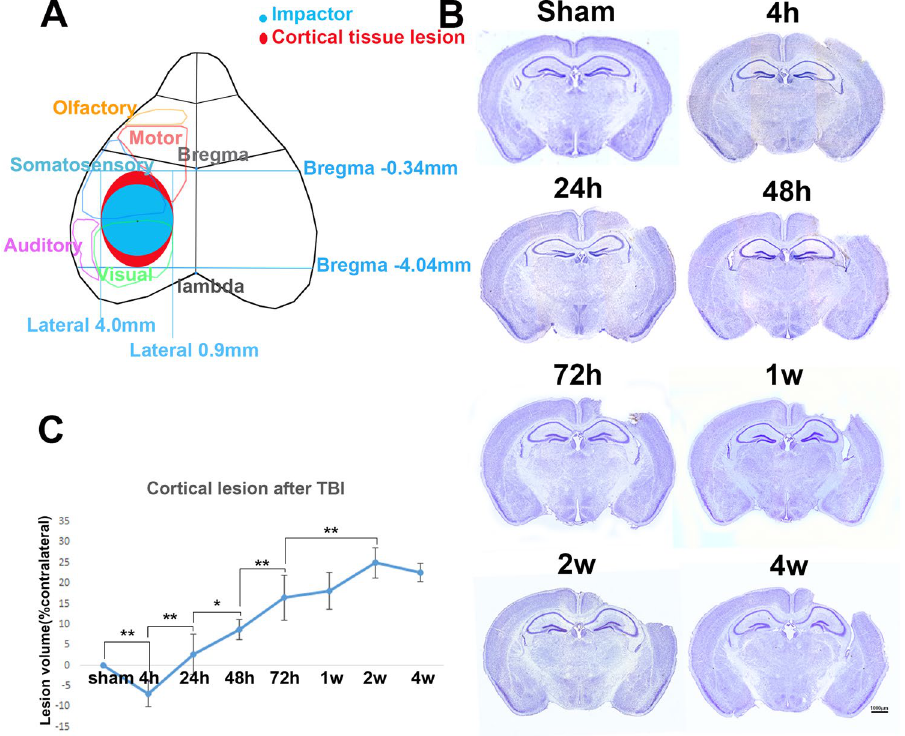
Figure 1. TBI caused an expanding cavity in juvenile cortex. ( A ) The illustration of the cortical tissue lesion after CCI surgery. ( B ) Nissl staining showed the temporal pattern of anatomical structure change. ( C ) Quantification of the cortical cavity (n = 4, * p < 0.05; ** p <